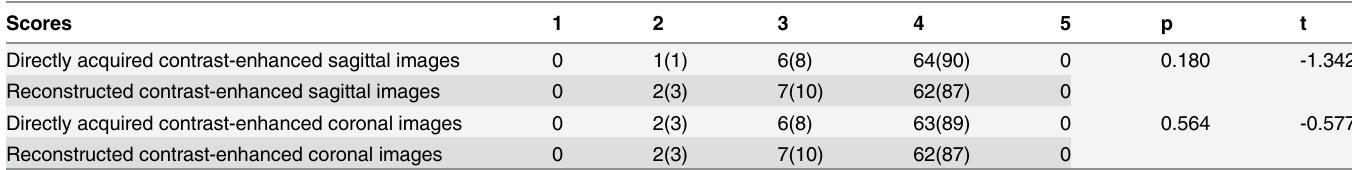
Table 2. Image quality scores.